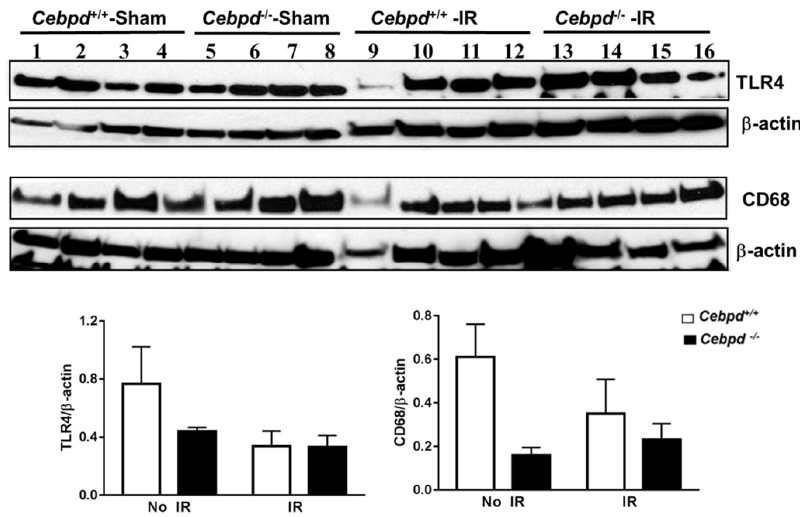
Figure 6. Expression of markers of inflammation and activated microglia in sham and irradiated Cebpd +/+ and Cebpd − / − hippocampal extracts of aged mice. Immunoblotting of TLR4 and CD68 normalized to β -actin used as a loading control, n = 4 mice per genotype per treatment.